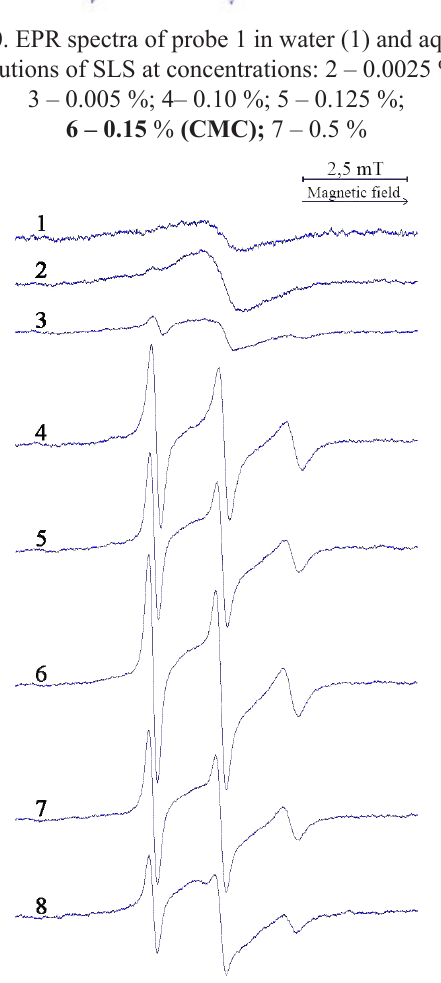
Fig. 11. EPR spectra of spin probe 2 in aqueous solutions of P338 at concentrations: 1 – 1 %; 2 – 5 %; 3 – 6 %; 4 – 10 %; 5 – 15 %; 6 – 17 %; 7 – 20 %; 8 – 25 %